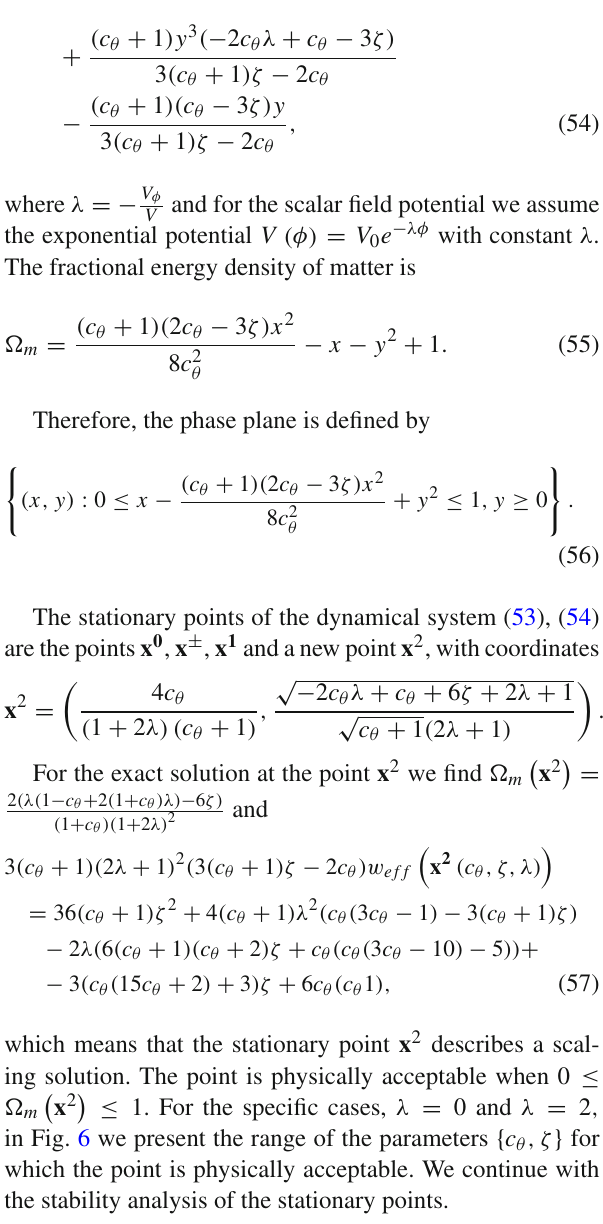
Fig. 4 Region plots in the space of parameters { c θ ,ζ } , where the stationary points: x 1 (left fig.), x + (middle fig.) and x − (right fig.) are attractors for the dynamical system with an exponential potential and λ = 2